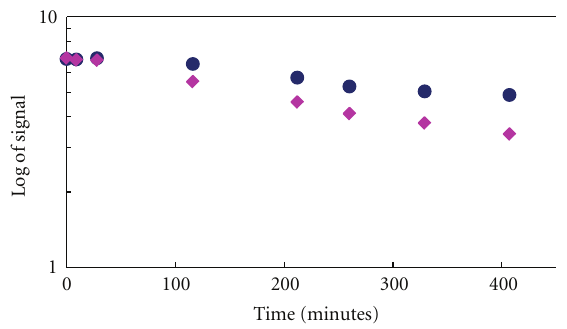
Figure 6: MRI intensity drop of Gd DTPA-BMA versus HWO1- 147 plotted against time. The semi-log plot is used to estimate the characteristic time of the signal drop for Gd DTPA-BMA (pink diamonds) versus HWO1-147 (dark circles), by calculating the magnitude of the slope for each